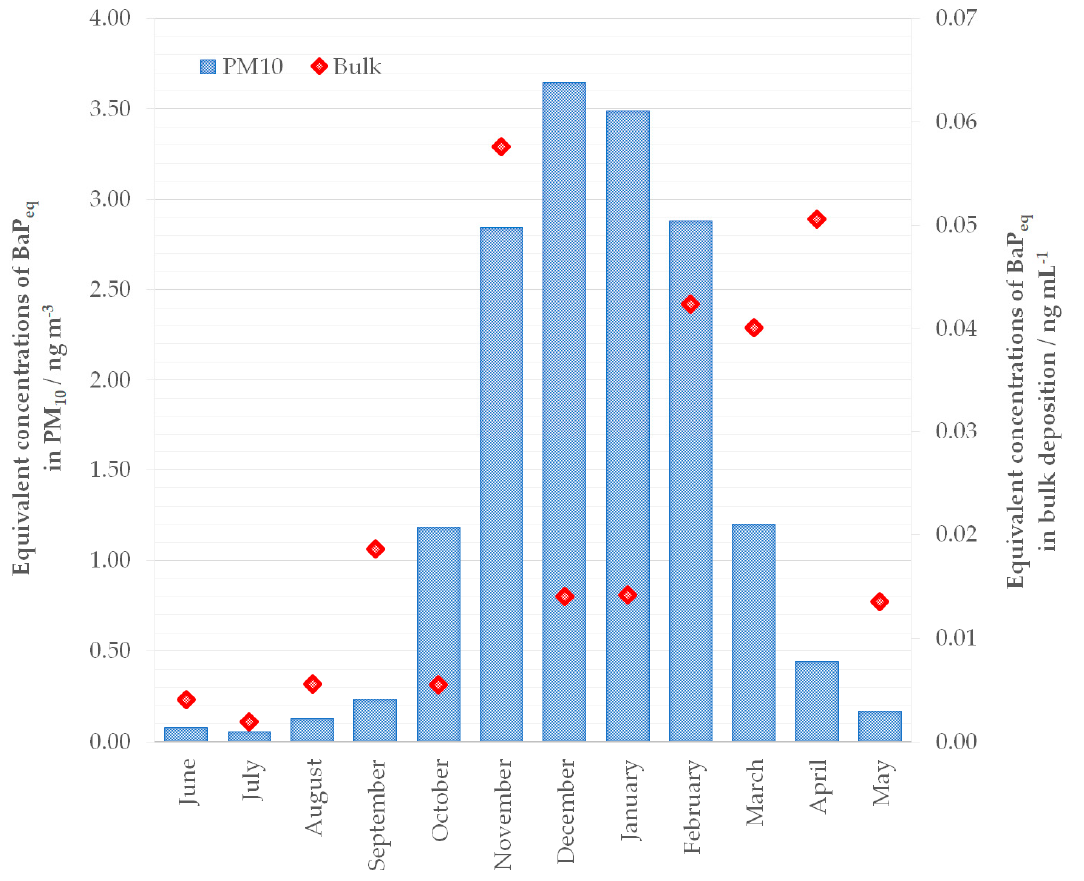
Figure 1. Monthly average equivalent ∑ BaP eq mass concentrations of PAHs in the PM 10 particle fraction and bulk deposition.